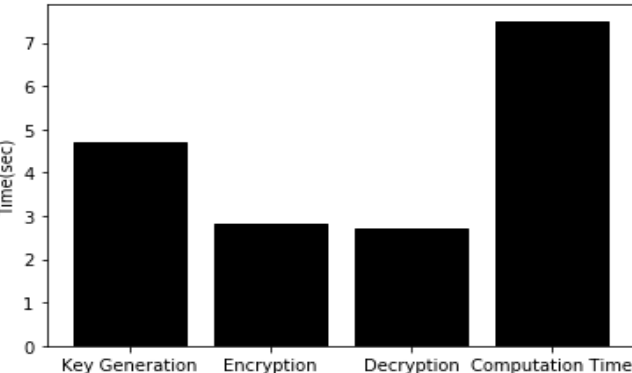
Figure 9. User partial key generation time by the GC.